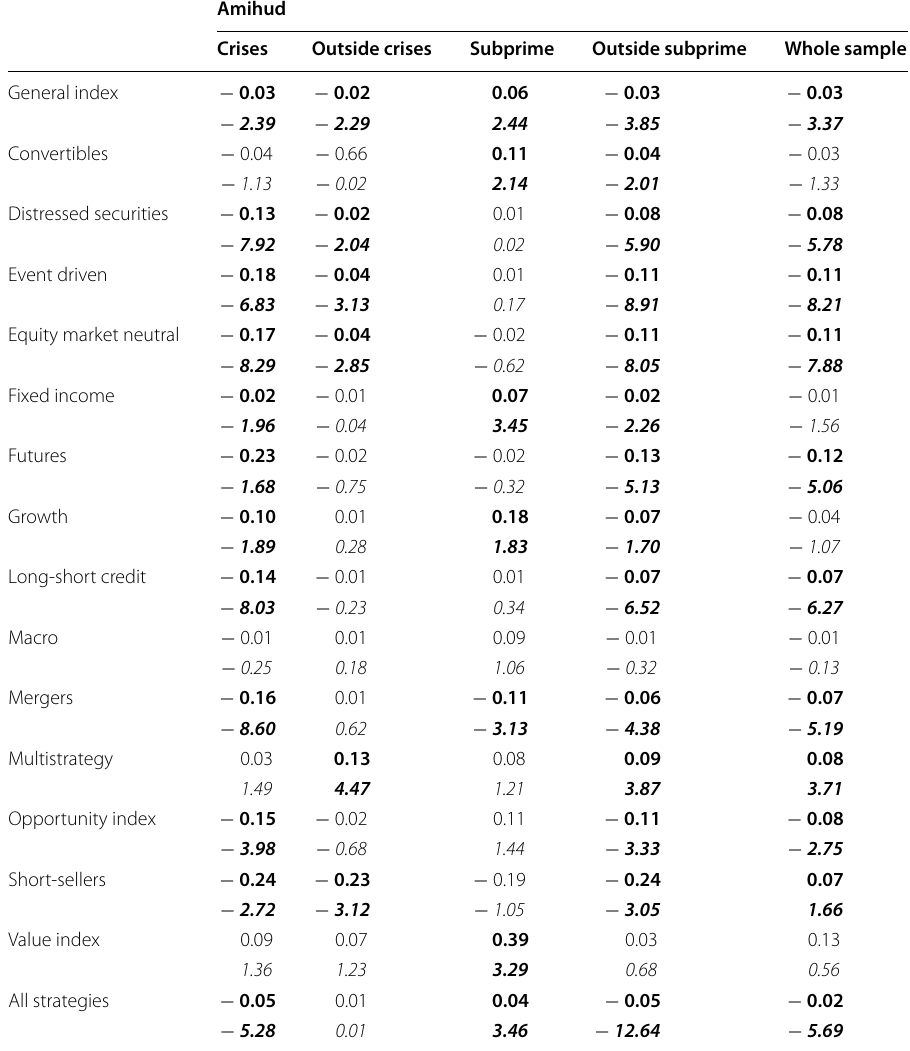
Table 7 Sensitivities of hedge fund strategies’ betas to the Amihud ratio using pooled regressions with fixed coefficients and SUR,